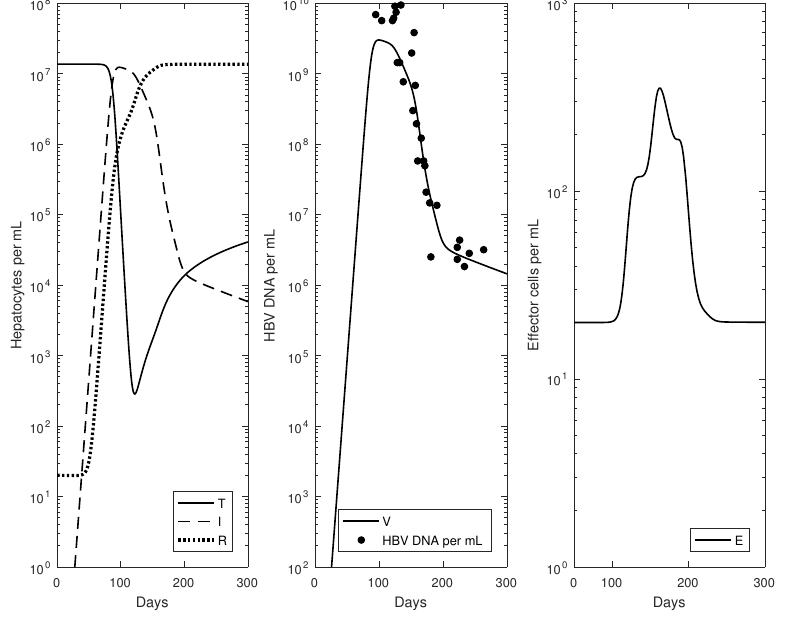
Figure 1. Temporal evolution for the variables in Model (1) without drug therapy, i.e., (cid:101) = η = 0, and the parameters in Table 1. The circles represent patient data.